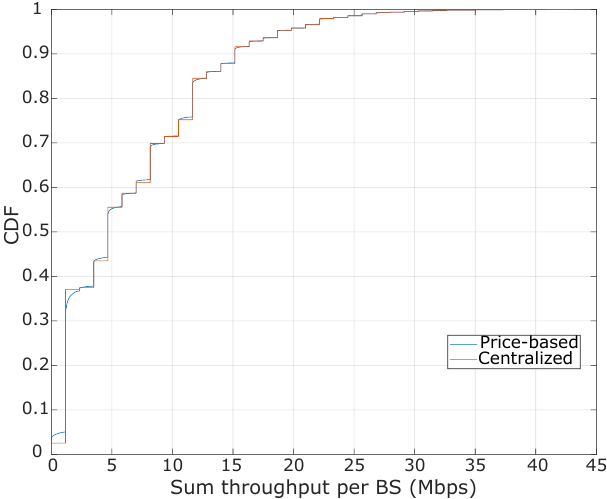
Figure 8. Average sum throughput per BS, where the system was configured with five devices (on average) uniformly distributed over each cell and with a R min c requirement of 250